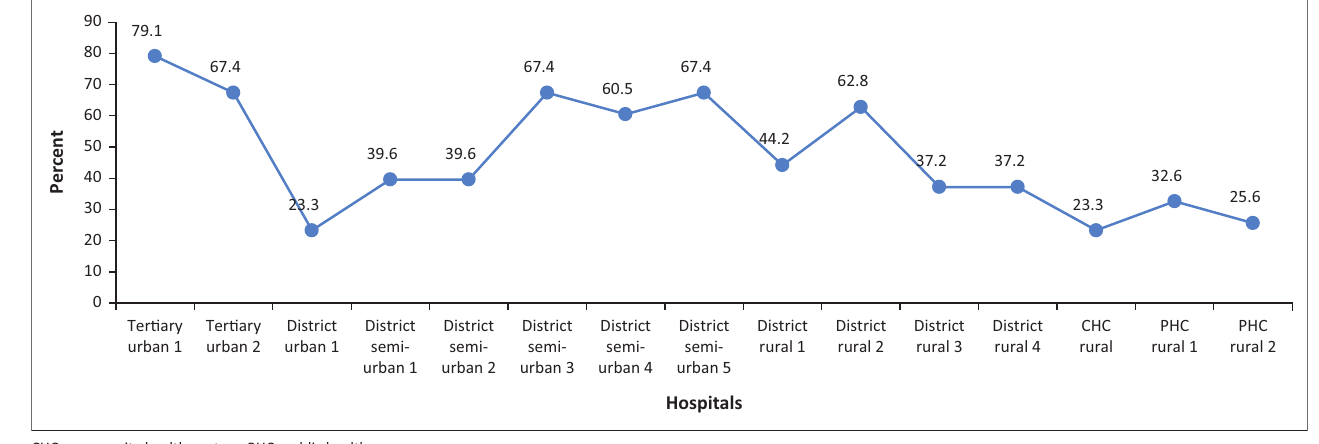
FIGURE 2: Total available equipment in KwaZulu-Natal eye health